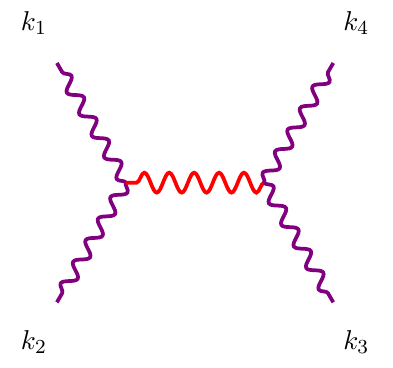
Figure 5 . Four photon amplitude due to exchange of a massive spinning